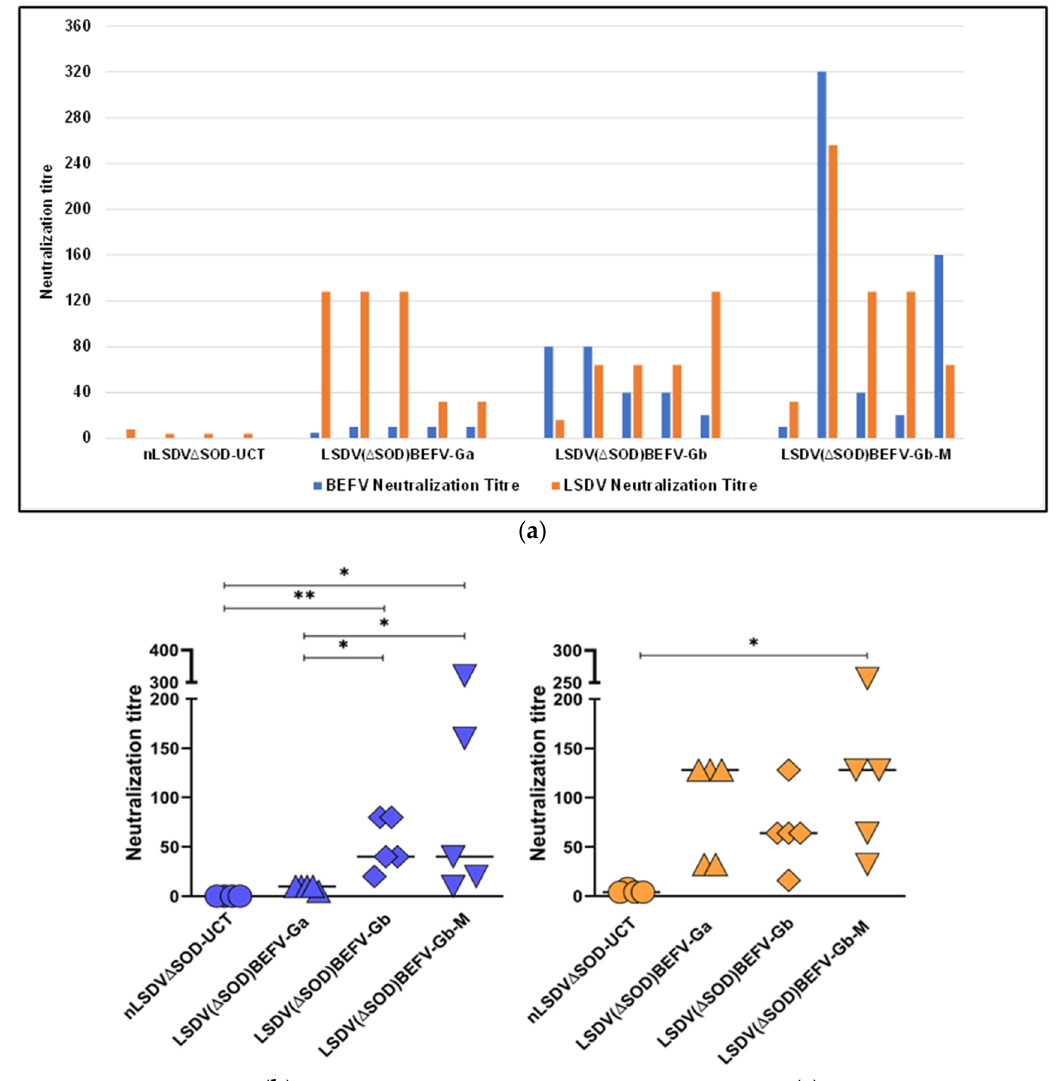
Figure 5. Comparison of dual vaccines expressing different BEFV gene inserts in a rabbit model. Rabbits were divided into groups of 5, and each animal was inoculated intramuscularly with 10 6 ffu of the respective vaccines LSDV( ∆ SOD)BEFV-Ga, LSDV( ∆ SOD)BEFV-Gb and LSDV( ∆ SOD)BEFV-Gb-M. nLSDV ∆ SOD-UCT was given to a group of 4 animals as a negative control for BEFV. Rabbits were given three doses of homologous vaccine at 28-day intervals and neutralization was tested on serum taken 14 days post final inoculation. Neutralization titres are expressed as the reciprocal of the dilution required to neutralize virus in 50% or more of wells of cells infected with BEFV or LSDV, respectively. ( a ) graph showing individual animal responses to both BEFV (blue) and LSDV (orange). BEFV (blue) and LSDV (orange) responses to the dual vaccines, expressing different BEFV inserts, were compared in ( b , c ) respectively. Statistical analysis was conducted using the Kruskal–Wallis test with Dunn’s multiple comparison test. Horizontal lines indicate median values. * p < 0.05, ** p < 0.01.